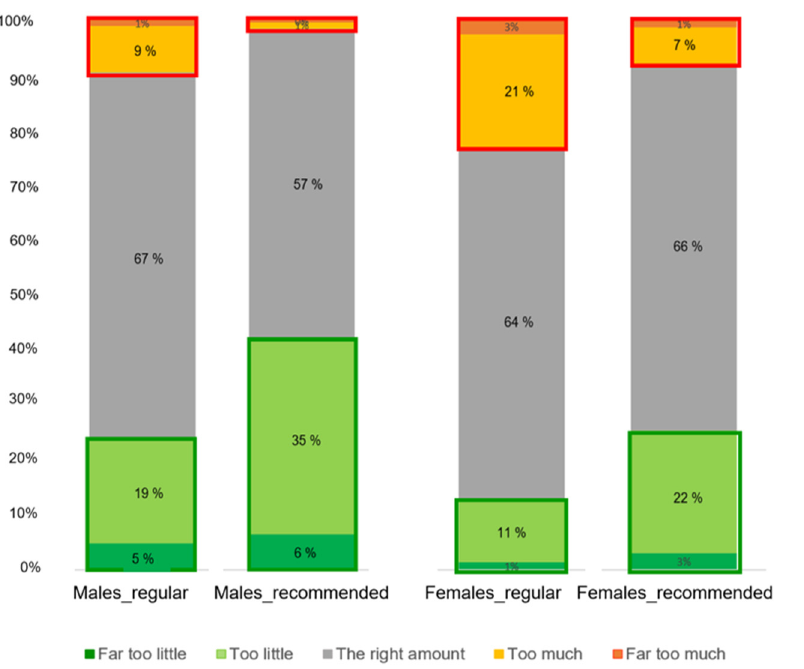
Figure 4. Bar plots of the perceived amount of meat in regular and recommended portion sizes across the five meals by gender.